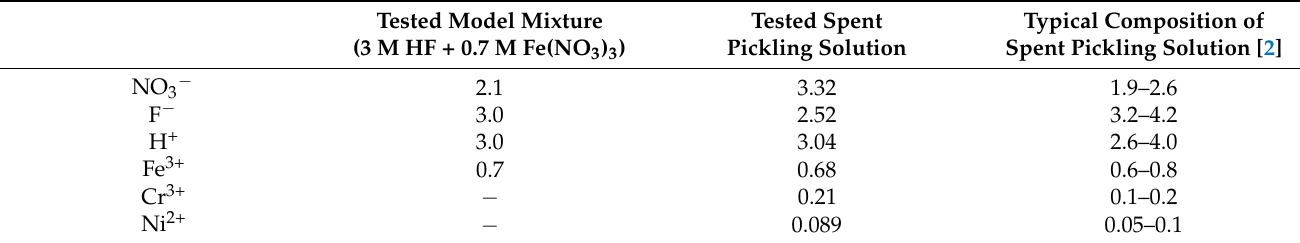
Table 1. The composition of tested solutions (mol L − 1 ).